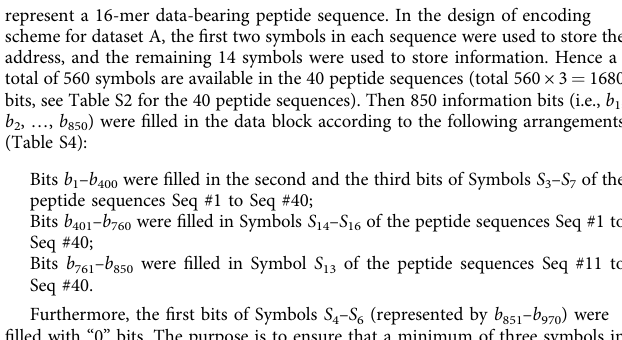
Fig. 3 The chromatogram for analysis of the peptide mixture encoding dataset